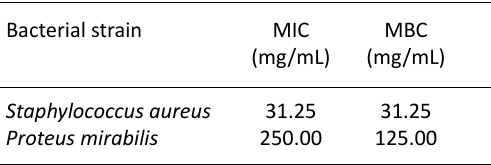
Table 4. MIC and MBC of the susceptible bacteria to doum methanolic extracts Bacterial strain MIC MBC